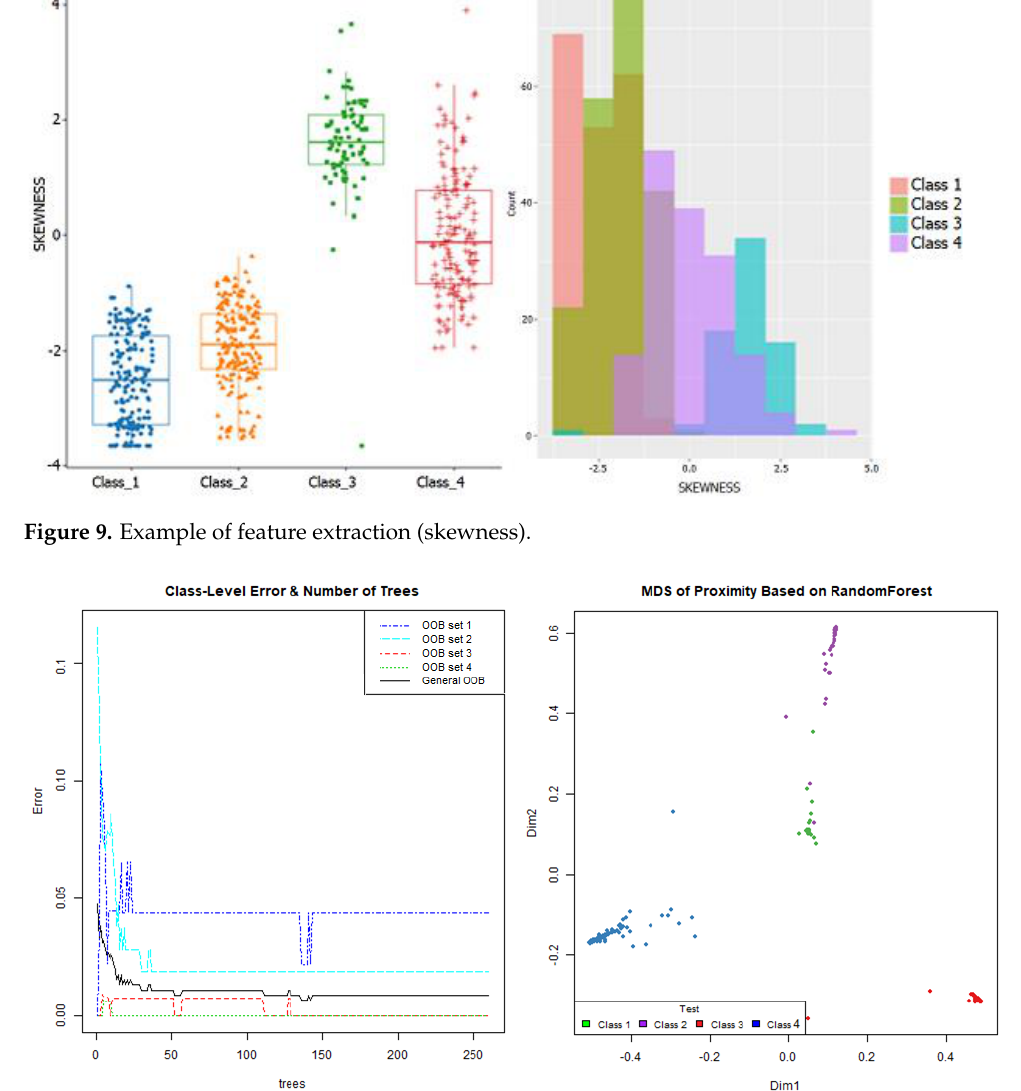
Figure 9. Example of feature extraction (skewness).